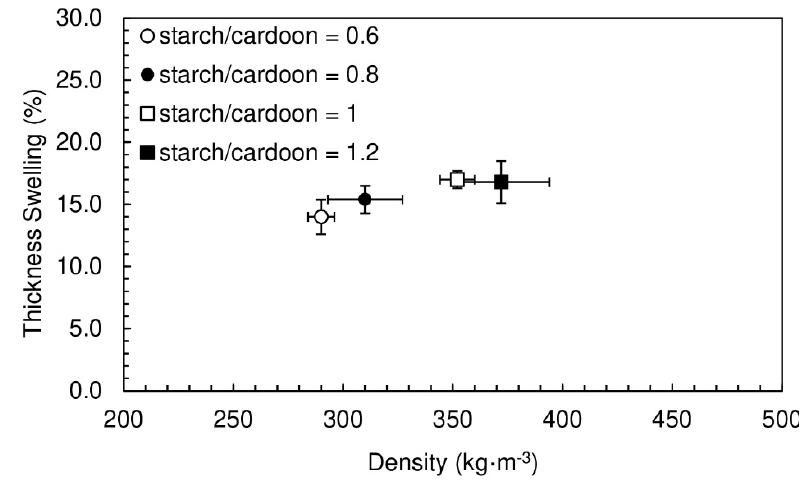
Figure 3. Thickness swelling of particleboards bonded with potato starch for starch/cardoon ratios of 0.6, 0.8, 1 and 1.2. All formulations had a water/starch ratio of 2.